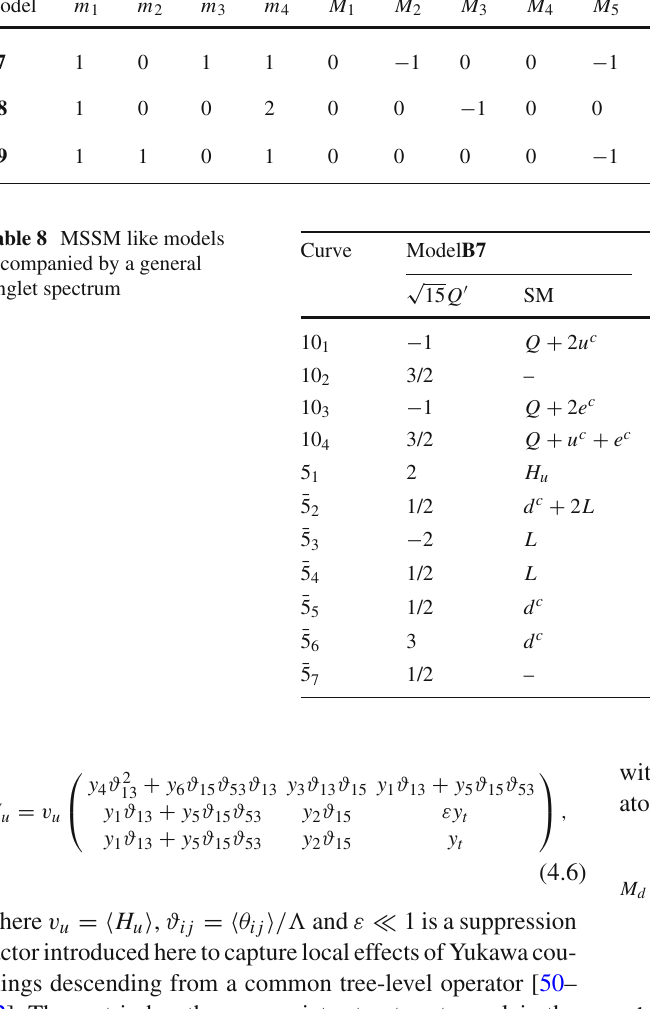
Table 7 MSSM flux solutions along with the corresponding c i ’s for a general singlet spectrum Model